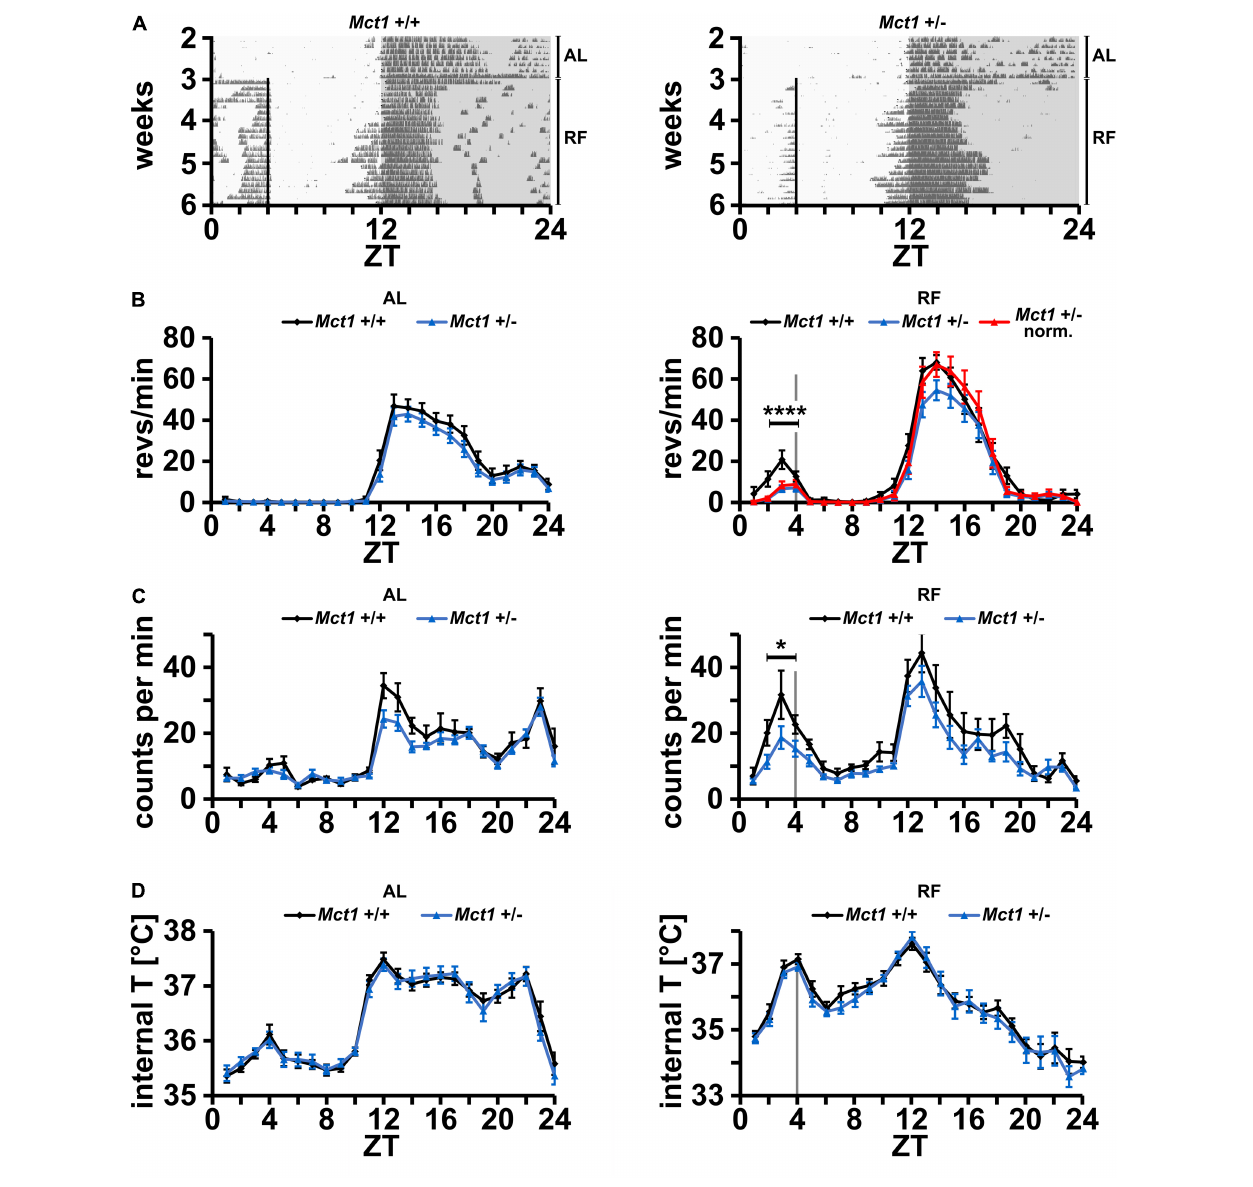
FIGURE 1 | Mice heterozygous for Mct1 display reduced FAA but have a normal temperature profile. (A) Examples of wheel-running actograms of Mct1 + / + (left panel) and Mct1 + / − mice (right panel) under ad libitum (AL) and daytime-restricted feeding (RF) conditions. The vertical line at ZT4 indicates the time of food access. (B) Quantified wheel-running activity plots under AL (left panel) and the last week of RF (right panel) conditions. Food anticipatory activity (FAA) under RF is significantly reduced in Mct1 + / − (blue) and normalized Mct1 + / − (red) compared to Mct1 + / + mice (black). Activity was normalized to dark phase activity of controls ( n = 13–15, 2-way ANOVA, **** p = 4.89 × 10 − 4 , F = 13.22). (C) Quantified general activity plots under AL (left panel) and RF (right panel) conditions. FAA under RF is significantly reduced in Mct1 + / − (blue) compared to Mct1 + / + mice (black) ( n = 8–9, 2-way ANOVA, * p = 0.01, F = 7.02). (D) Internal body temperature profiles under AL (left panel) and RF (right panel) conditions. No differences were observed between the genotypes under both AL and RF conditions ( n = 8–9, 2-way ANOVA, p > 0.05). Error bars represent the standard error of